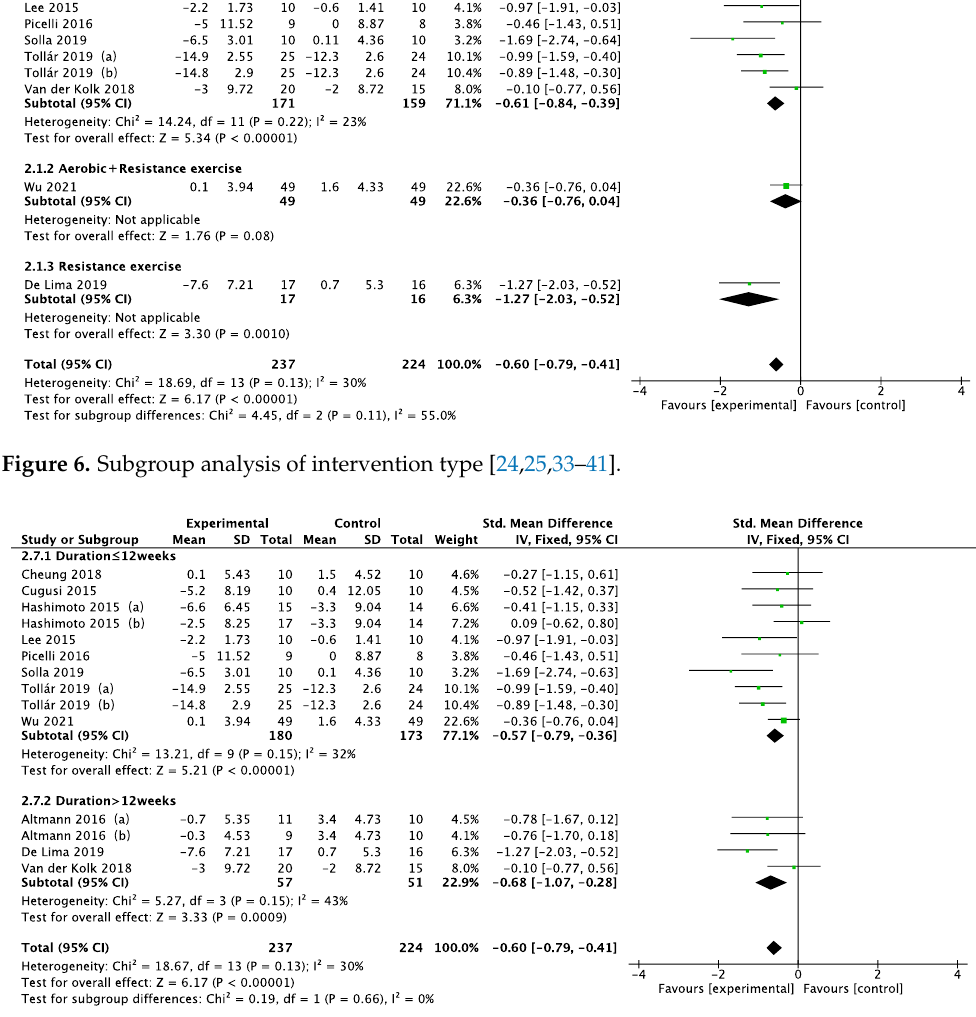
Figure 7. Subgroup analysis of intervention period [24,25,33 – 41].